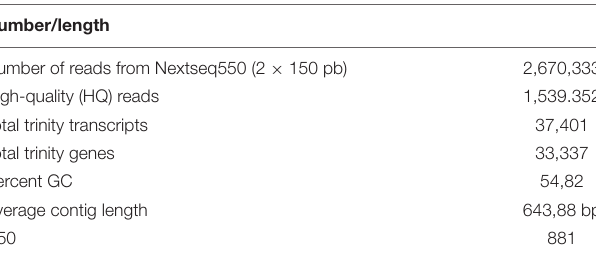
TABLE 1 | Transcriptome sequencing and summary statistics of de novo